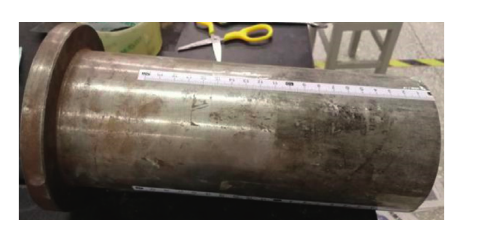
Figure 6: Particle size distribution of samples before and after direct